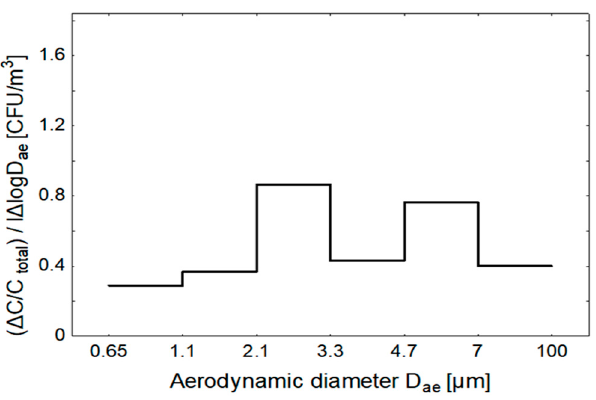
Figure 6. Size distribution of bacterial aerosols recorded at the minimum UV radiation value (39 W/m 2 ).